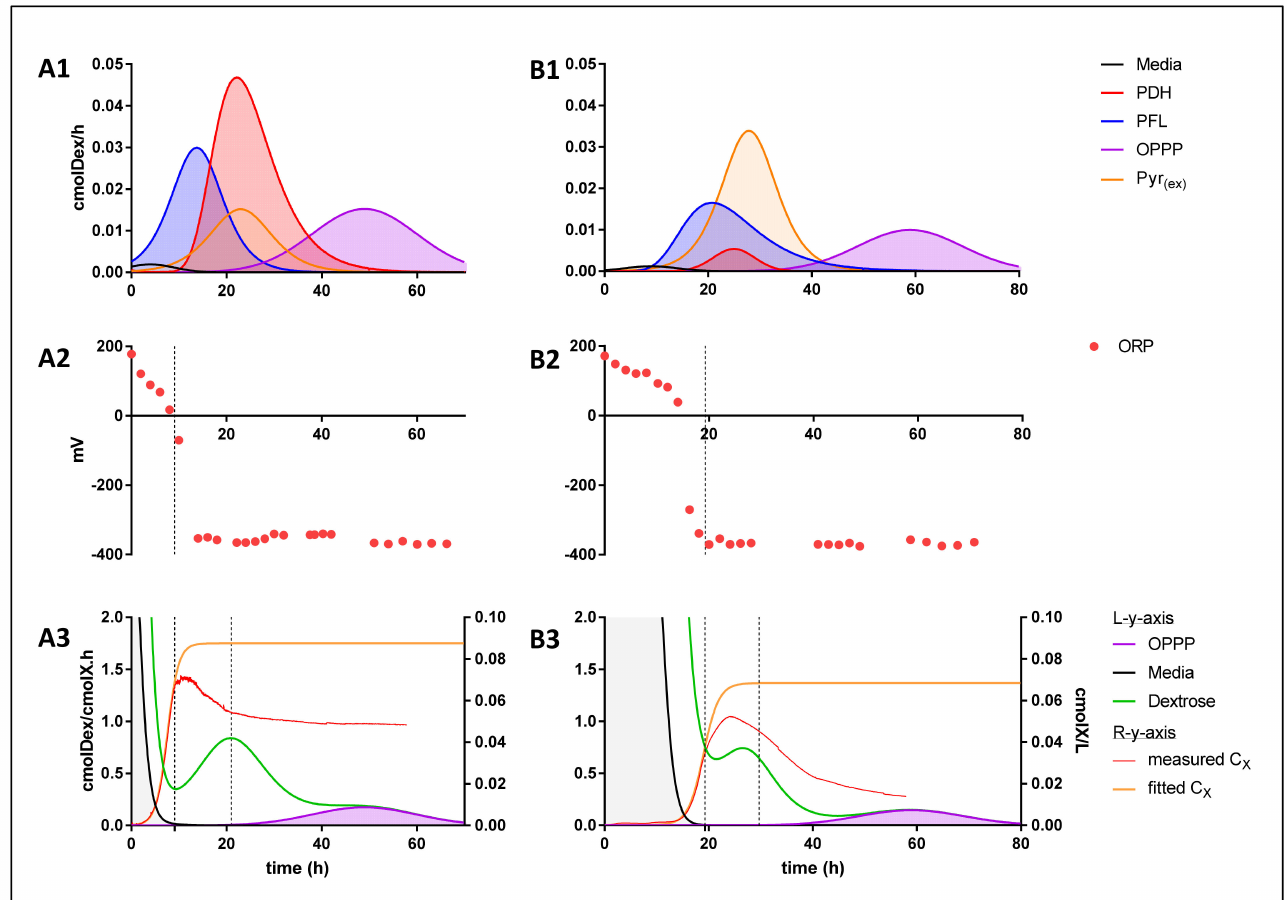
Figure 5. ( A1 , B1 ) Volumetric dextrose consumption rate as it relates to the specific energy production pathways utilised, both media display preference to pathways with higher energy extraction efficiencies, sequentially substituting them for pathways with lower energy extraction efficiencies as fermentation progresses. ( A2 , B2 ) Measured ORP data. ( A3 , B3 ) [left y-axis]) Depiction of cell-based dextrose consumption rates (green), and cell-based dextrose consumption rates as it relates to the media mediated (ORP) energy extraction pathway (grey) and OPPP energy extraction pathway (purple). [right y-axis]) Measured (red) and fitted (orange) biomass concentration curves; A correlation coupling the onset of flocculation to termination of the ORP energy extraction pathway is